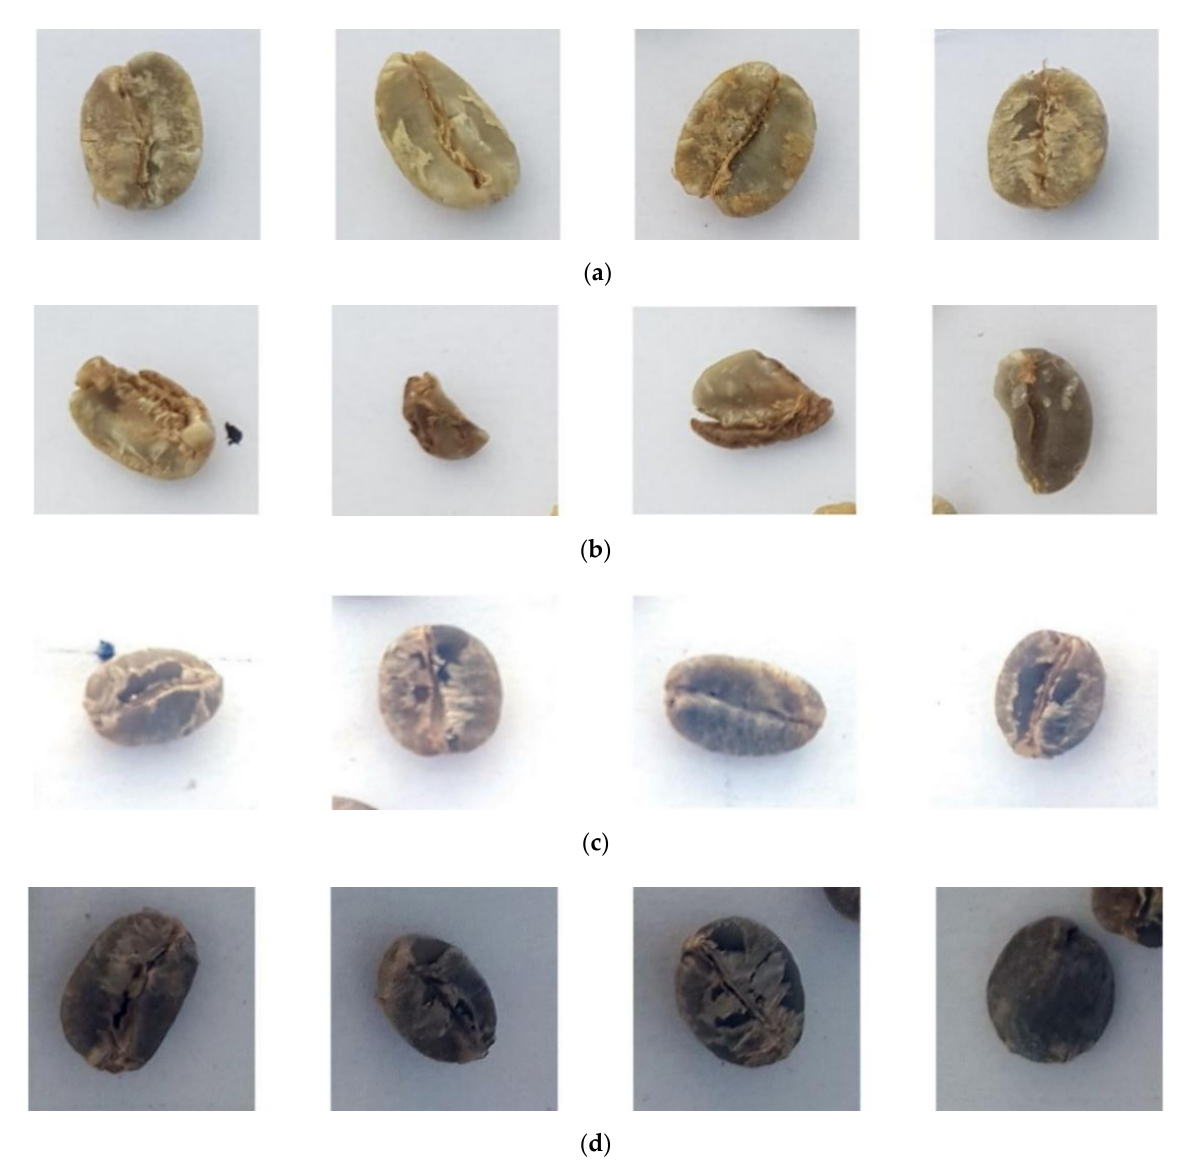
Figure 13. Green coffee bean dataset: small optical sorter: ( a ) good, ( b ) bad, ( c ) increased brightness, ( d ) reduced brightness.